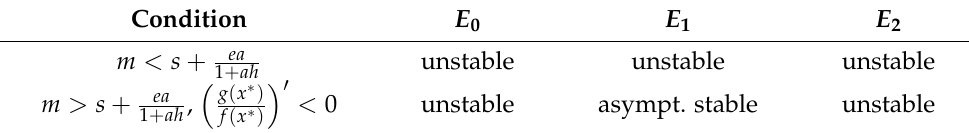
Table 5. Conditions for feasibility and stability of the trivial equilibria of the system in (45) and (46). Condition